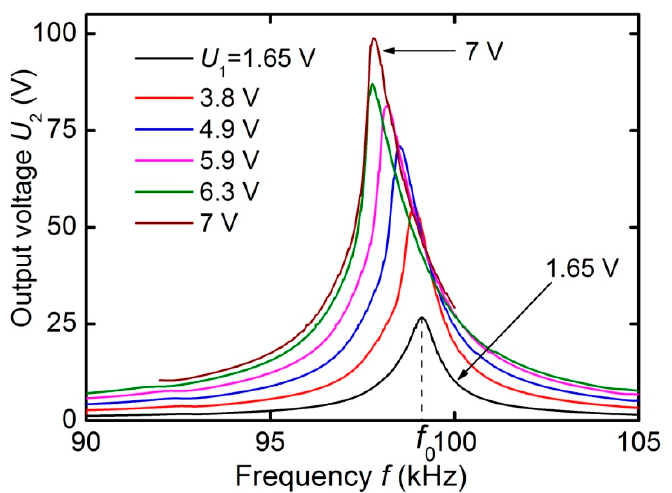
Figure 8. Dependences of the output voltage U 2 of the transformer on the frequency f of the input voltage at various amplitudes of U 1 (1.65 V–7 V) under open-circuit condition and H m ≈ 6.37 kA/m.